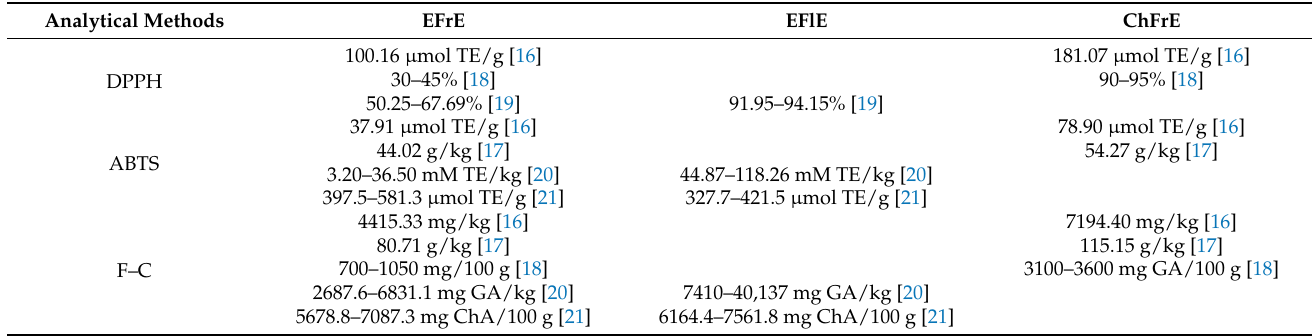
Table 2. Antioxidant capacity and total phenolic content in elderberry, elderflower, and chokeberry extracts, as determined by other